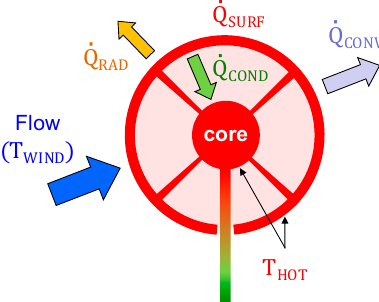
Figure 1. Heat flux components actuating on the surface of the spherical sensor. To minimize the thermal conduction losses between them, the temperatures of both the surface, T SURF , and of the core of the support structure, T CORE , are forced to be T HOT .